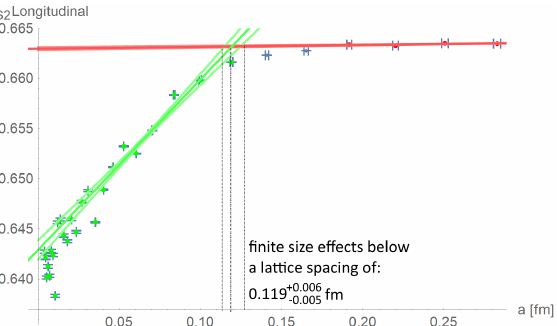
Figure 4. The S2-Homogeneity on the vortex surface is shown for an 8 4 -lattice for different lattice spacings. The data points, used for the fit of the upper, nearly horizontal red line are marked in red. The green line at small values of the lattice spacing a is fit to the green data points. The allocation of the data points to the lines is based on minimizing the sum of horizontal and vertical squared deviations. For both lines, a mean prediction band is calculated, and the respective intersections define the lattice spacing below which finite size effects dominate. Multiplying this lattice spacing with the lattice size gives the physical size of the homogeneous